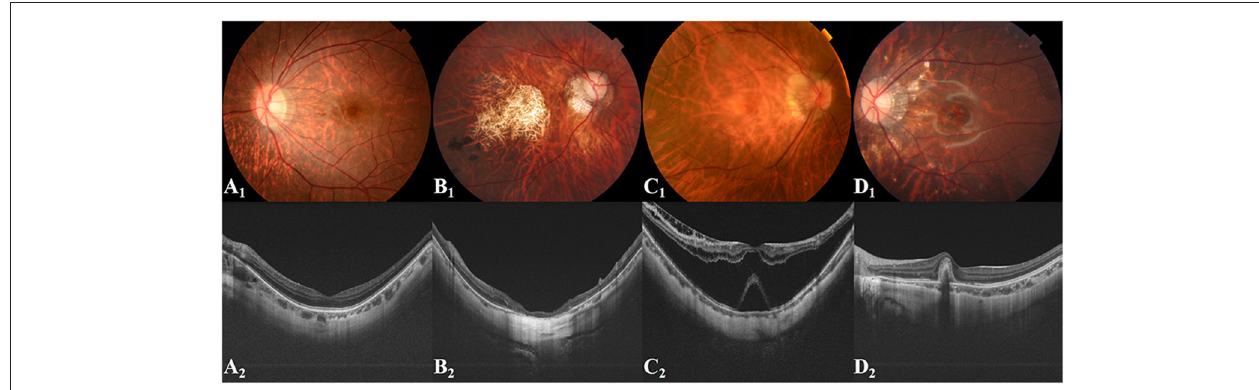
FIGURE 2 | Representative fundus images and related OCT images. (A 1 ,A 2 ) Tessellated fundus; (B 1 ,B 2 ) Macular atrophy; (C 1 ,C 2 ) Retinal detachment; (D 1 ,D 2 ) PMCNV. OCT, optical coherence tomography; PMCNV, pathological myopic choroidal neovascularisation.